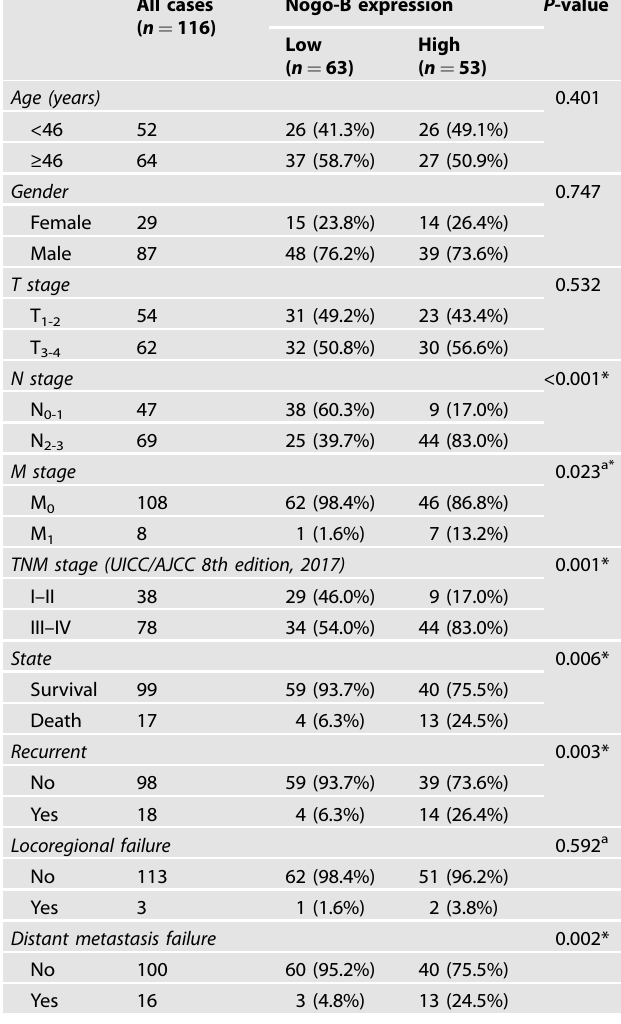
Table 1. Correlation between the expression of Nogo-B and the clinicopathologic features of